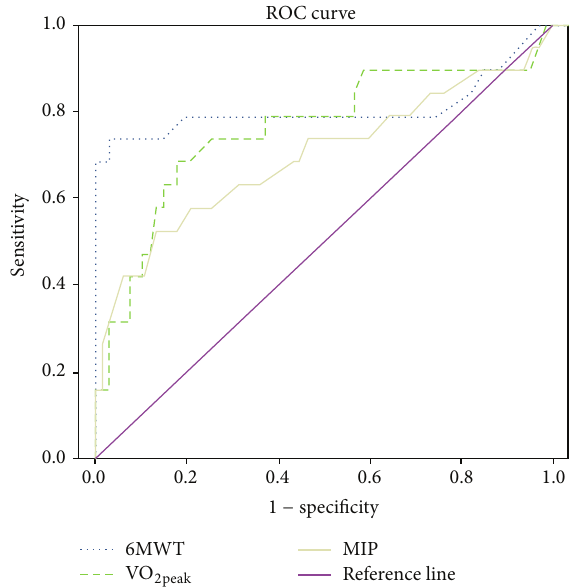
Figure 4: The 6MWT had an area under the ROC curve of 0.87, with a sensitivity of 92% and a specificity of 31%. The VO 2 peak had an area under the ROC curve of 0.78, with a sensitivity of 87% and a specificity of 41%. MIP had an area under the ROC curve of 0.69, with a sensitivity of 71% and a specificity of